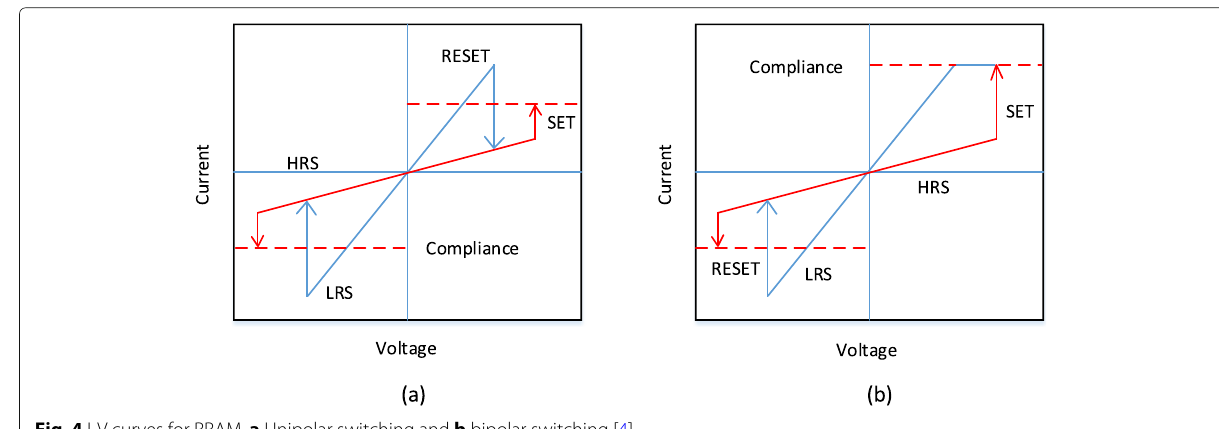
Fig. 4 I-V curves for RRAM. a Unipolar switching and b bipolar switching